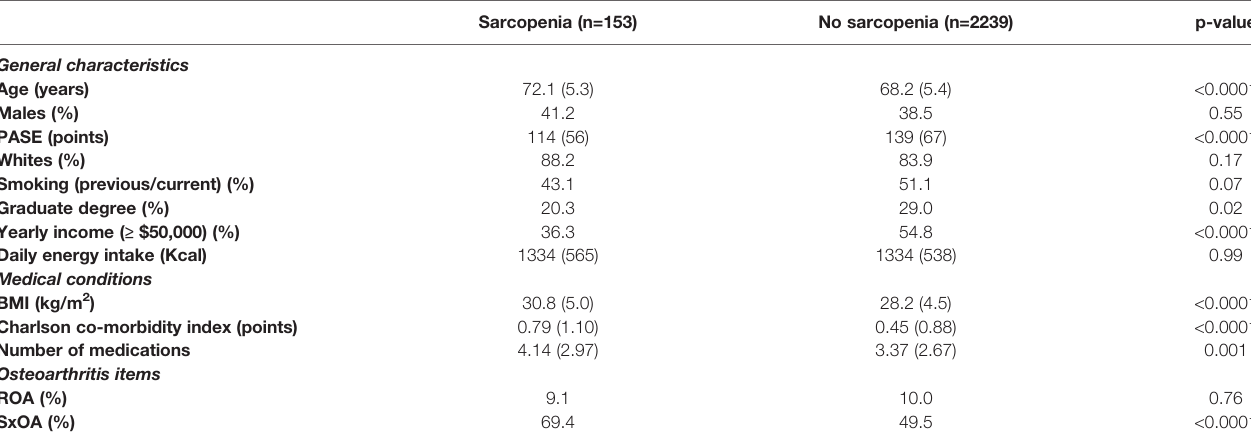
TABLE 1 | Baseline characteristics of participants according to the presence of sarcopenia.